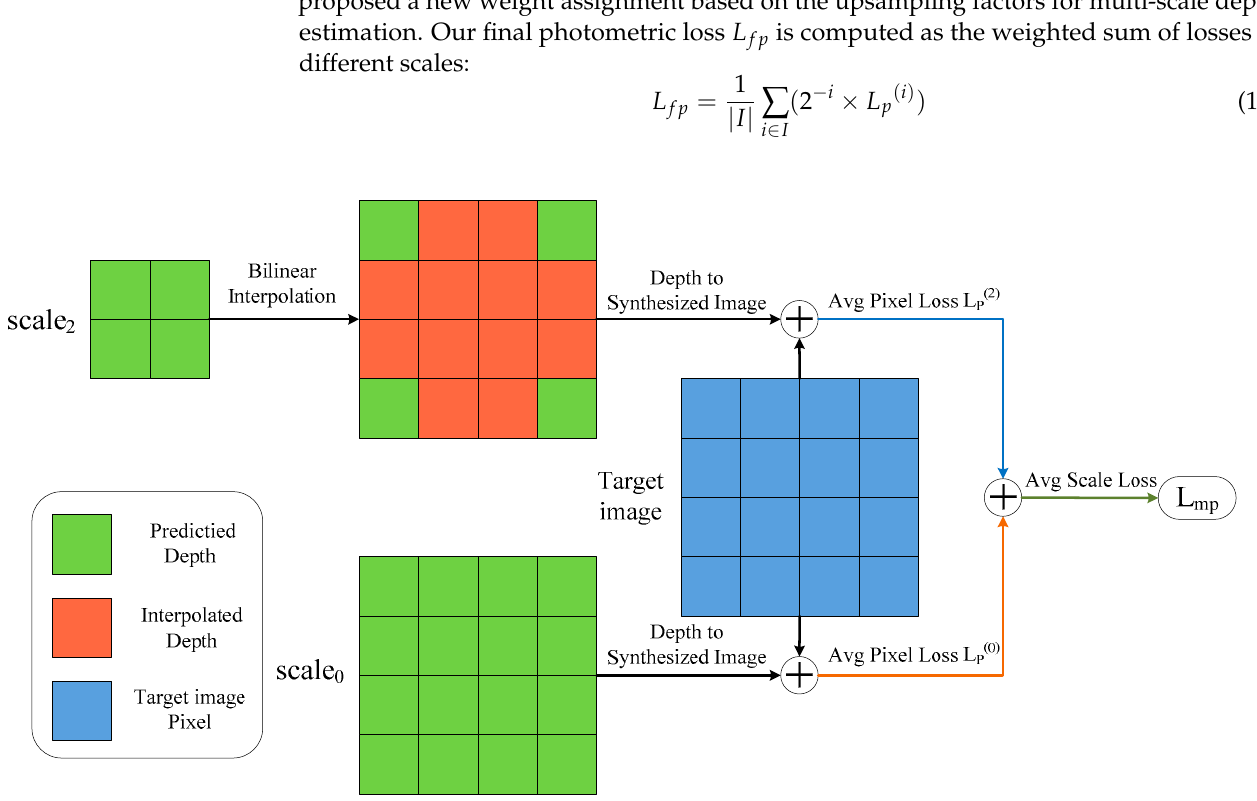
Figure 5. Analysis of the problem with calculating L mp in Monodepth2. Here we take only two of the four depth maps with different scales for our analysis and we adopt bilinear interpolation to implement the upsampling of depth maps.